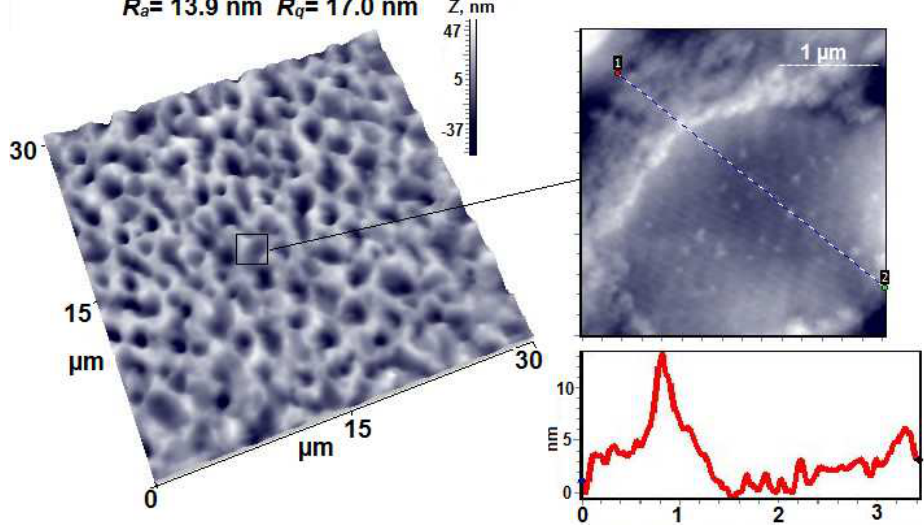
Figure 10. AFM 3D and height images and a line profile of PVA–pDMAEMA 90/10.